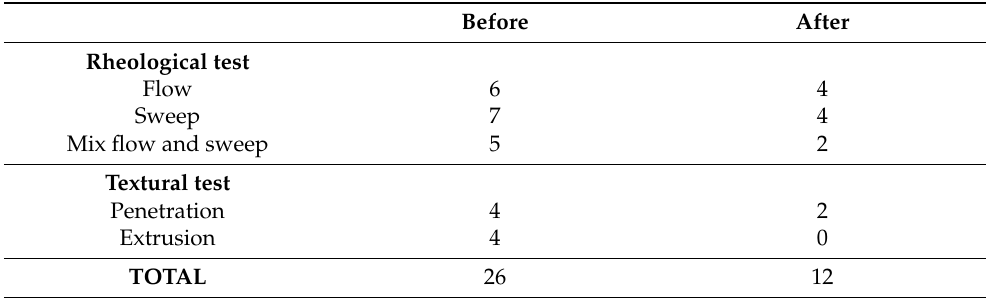
Table 12. Number of parameters for each method before and after the screening methodology. Before After